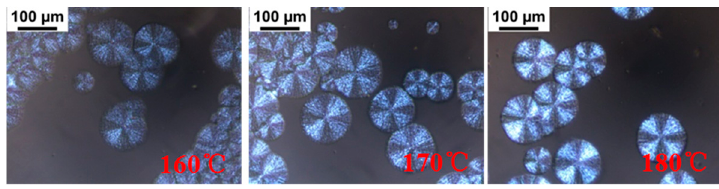
Figure 9. POM images of PLLA/PDLA-PEG 4k -PDLA600 isothermally crystallized at different temperatures.